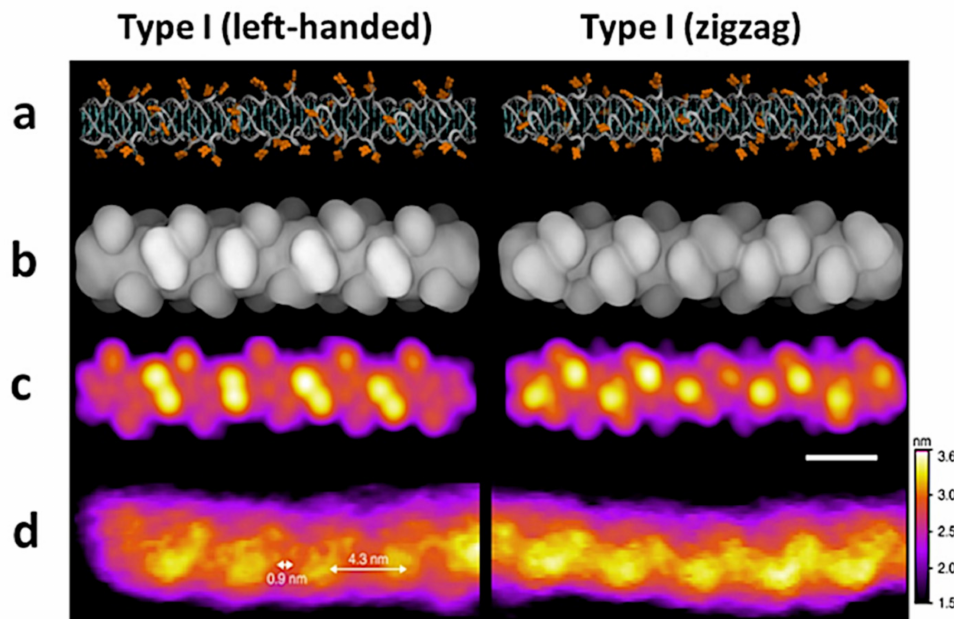
Figure 7. An experimental and theoretical results of molecular structure visualization of type I G-wires showing two types of periodic features: left-handed and zigzag: ( a ) the structural model, thymines are marked in orange. ( b ) Surface representation of ( c ) a simulated AFM images, ( d ) HR AM-AFM, the length of scale bar is 4nm. Images reproduced under the CC BY license from Bose, K.; Nat. Commun. ; published by Springer Nature, 2018.